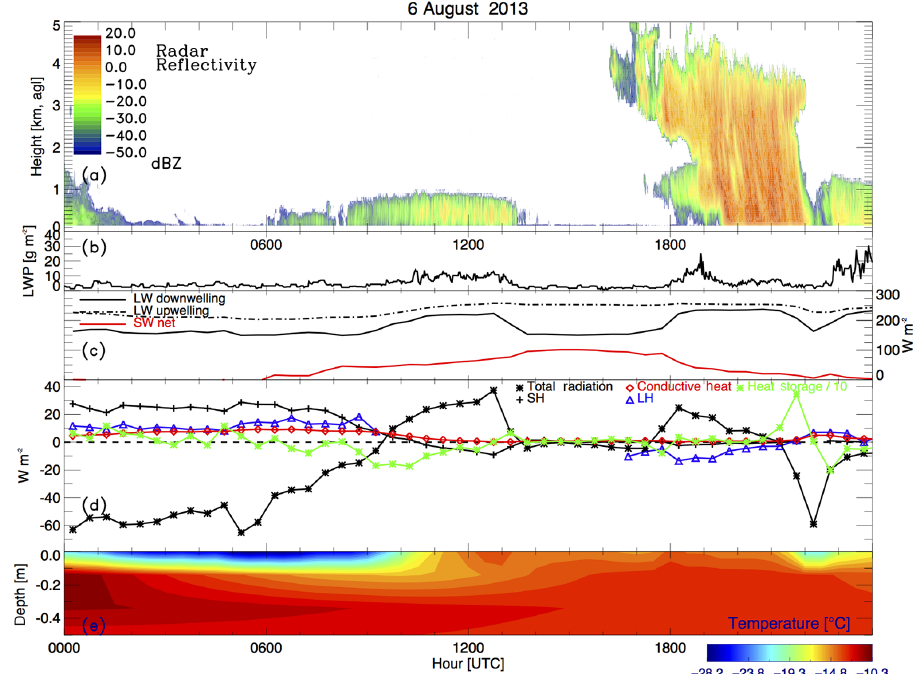
Figure 6. A case study on 6 August. (a) Cloud occurrence as seen by the MMCR; (b) liquid water path; (c) longwave upwelling, longwave downwelling, and net shortwave radiation; (d) surface energy fluxes: total radiation, sensible heat, conductive heat, and heat storage/10.0; and (e) subsurface